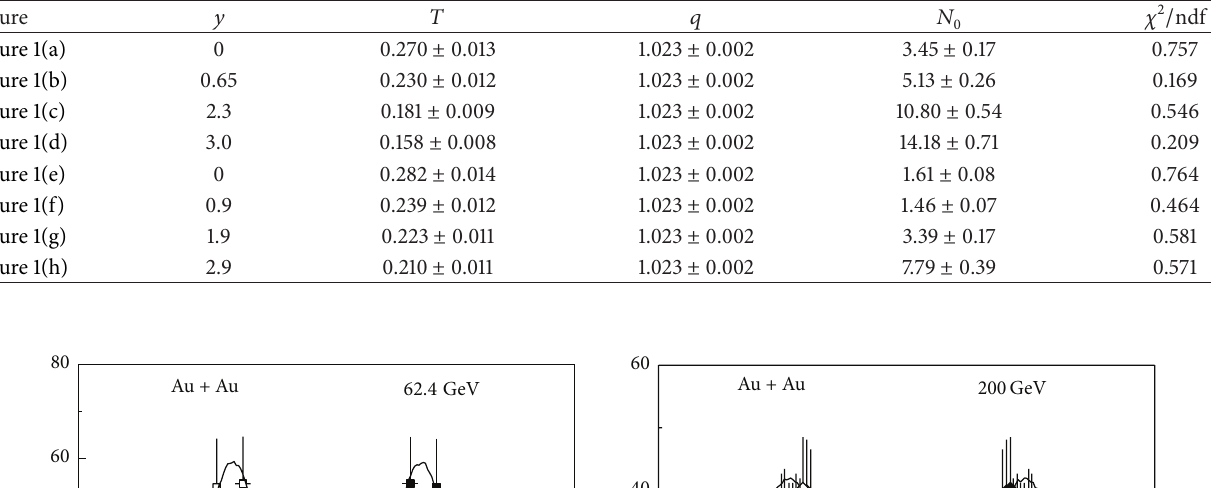
Table 1: Values of parameters and 𝜒 2 / ndf corresponding to the fits in Figure 1, where Figures 1(a)–1(d) are for central Au-Au collisions at 62.4 GeV and Figures 1(e)–1(h) are for central Au-Au collisions at 200 GeV. The unit of 𝑇 is GeV. The last three points in Figure 1(h) have not been included in the calculation of 𝜒 2 / ndf due to the low statistics.